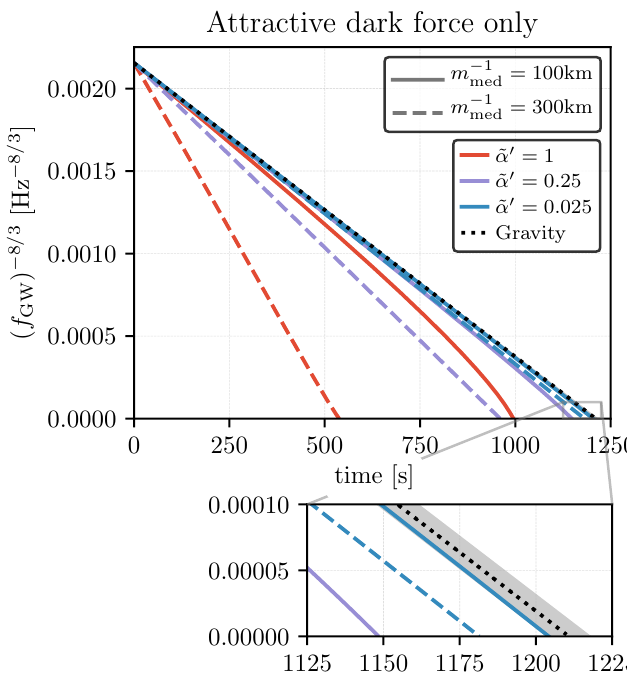
Figure 1 . Gravitational wave frequency f (cid:0) 8 = 3 ( t ) as a function of time for a neutron star binary GW with various values of the (cid:12)fth-force parameters e (cid:11) 0 and m med . In particular, we show results for m (cid:0) 1 = f 100 ; 300 g km (solid, dashed lines) and three choices of e (cid:11) 0 = f 1 ; 0 : 25 ; 0 : 025 g (red, med purple, and blue colored lines). We consider here the limit that the system loses energy only by gravitational wave emission, but not by radiation of light mediator particles. This situation is realized approximately if the binary partners have equal dark charge-over-mass ratios. The gray band indicates the typical error on reconstructing the chirp mass, which we conservatively take to be 0.4% based on ref. [4]. The boundary condition of the di(cid:11)erential equation is the threshold sensitivity of LIGO, f GW (0) = 10 Hz [67]. The neutron star masses are M 1 = M 2 = 1 : 25 M (cid:12)